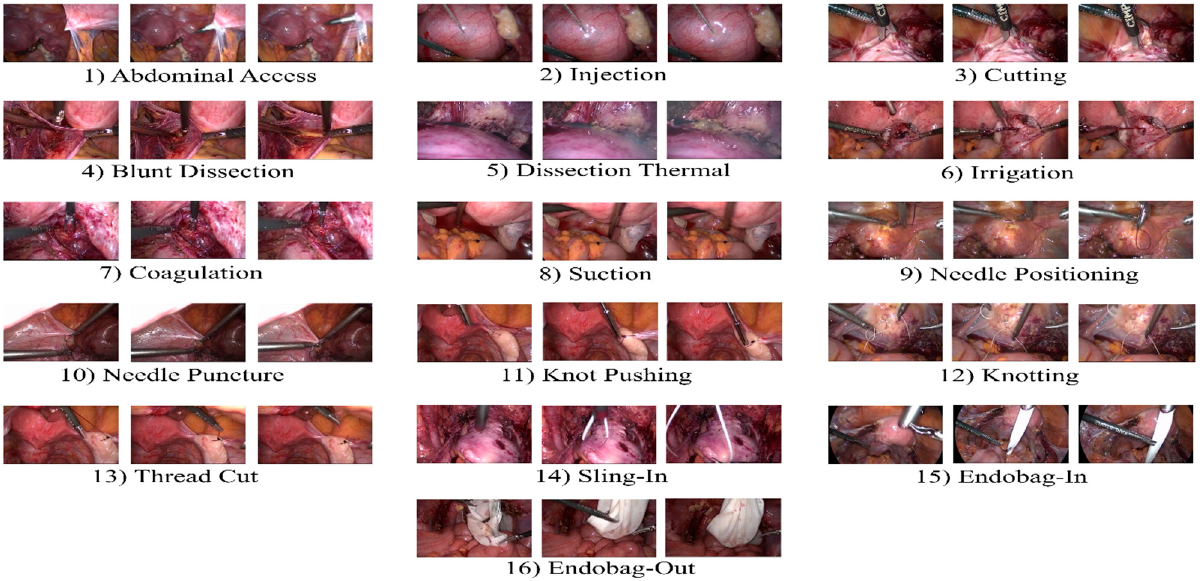
Figure 5. Overview of 16 different surgical actions in gynecologic laparoscopy.